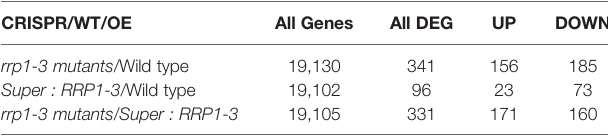
TABLE 1 | The differentially expressed genes among the transgenic and wild type plants by RNA-seq. CRISPR/WT/OE All Genes All DEG UP DOWN rrp1-3 mutants /Wild